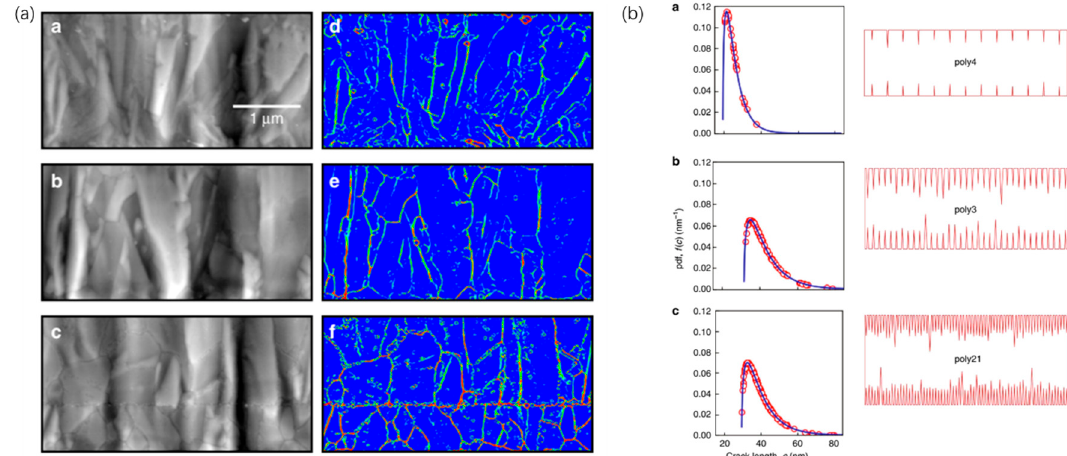
Figure 13. ( a ) Defects on the sidewall of the sample observed by AFM ( b ) The structural strength predicted based on the statistical distribution of the surface defect [126].